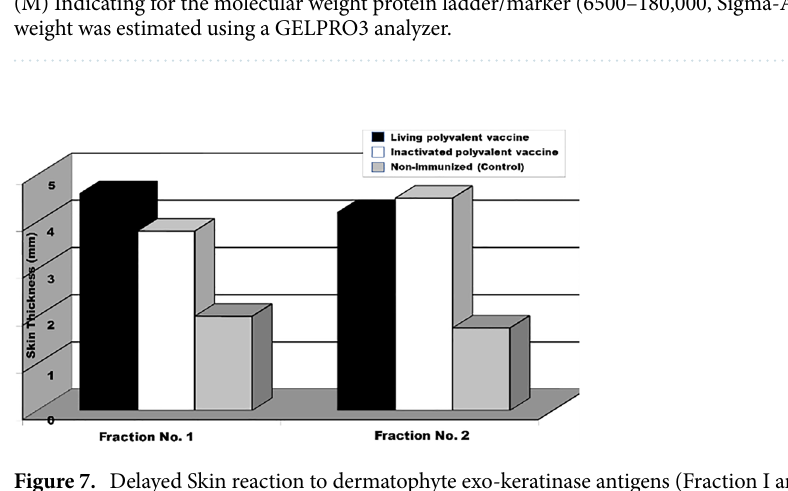
Figure 6. SDS-PAGE of culture supernatant of dermatophyte species grown on mineral medium containing 3 g/L keratin for identification of dermatophyte exo-keratinase based on the molecular weight. Lanes 1, 2, 5, and 6 showed 28 kDa bands (Fraction II) while 9 and 10 showed 42.5 kDa for the same fraction, and Lanes 3, 4, 7, and 8 showed 41 kDa bands (Fraction I), while 11 and 12 showed 27 kDa bands for the same fraction.